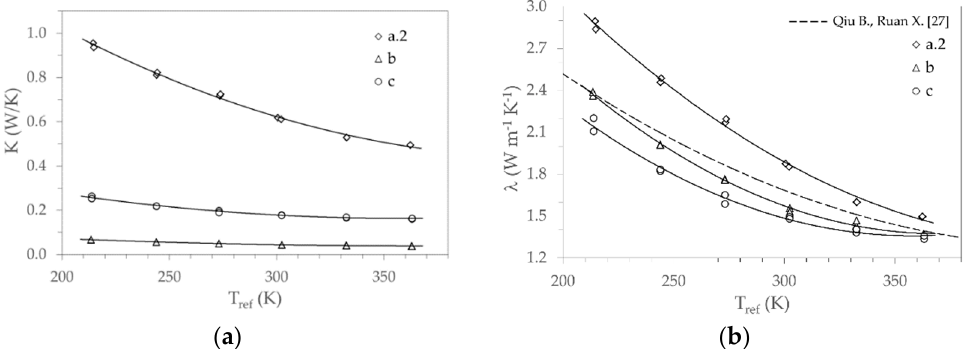
Figure 7. ( a ) Thermal conductance versus the reference temperature of the test for modules a.2, b, and c.; ( b ) Equivalent thermal conductivity of the assembled thermoelectric materials versus the reference temperature of the test for modules a.2, b, and c. The dashed line represents a possible trend in temperature of the average thermal conductivity for p and n doped Bi 2 Te 3 bulk materials, as found in the literature [27].